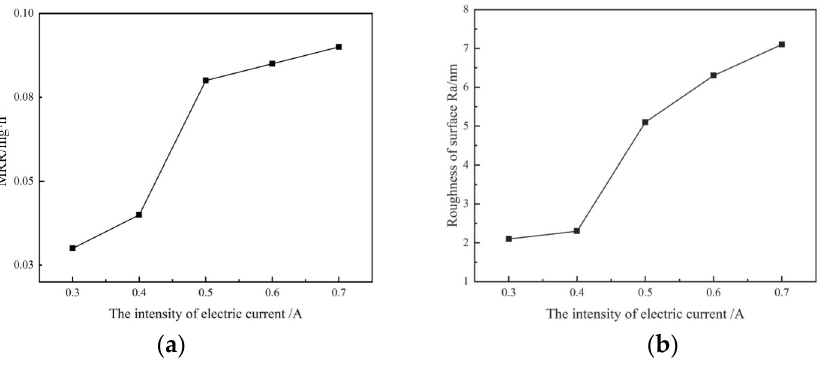
Figure 5. Curves of the material removal rate and roughness with the current intensity. ( a ) Curve of material removal r. ( b ) Curve of surface